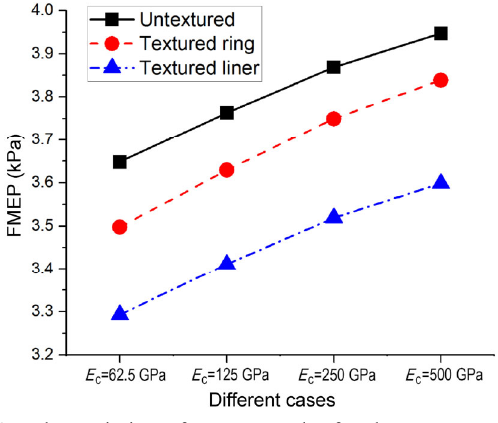
Fig. 8 The variation of FMEP results for the untextured and textured conjunctions under the warm engine condition when different elasticity modulus of coatings are adopted.